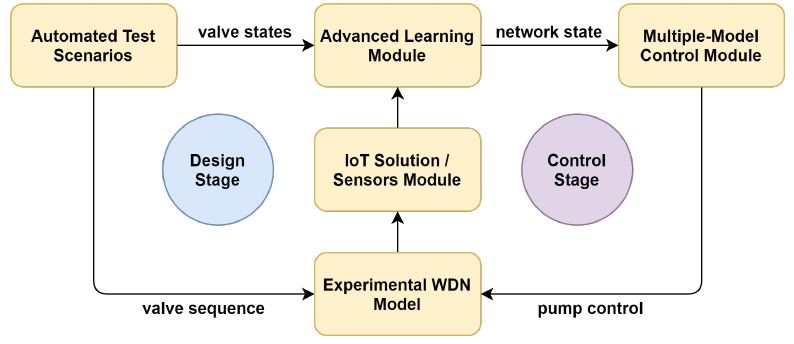
Figure 1. Proposed solution